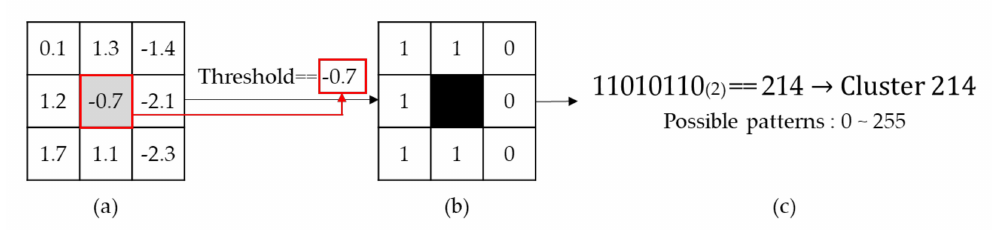
Figure 4. 8-bit binary patterning of 3 × 3 filter: ( a ) original value; ( b ) binary value; and ( c ) 8-bit binary pattern